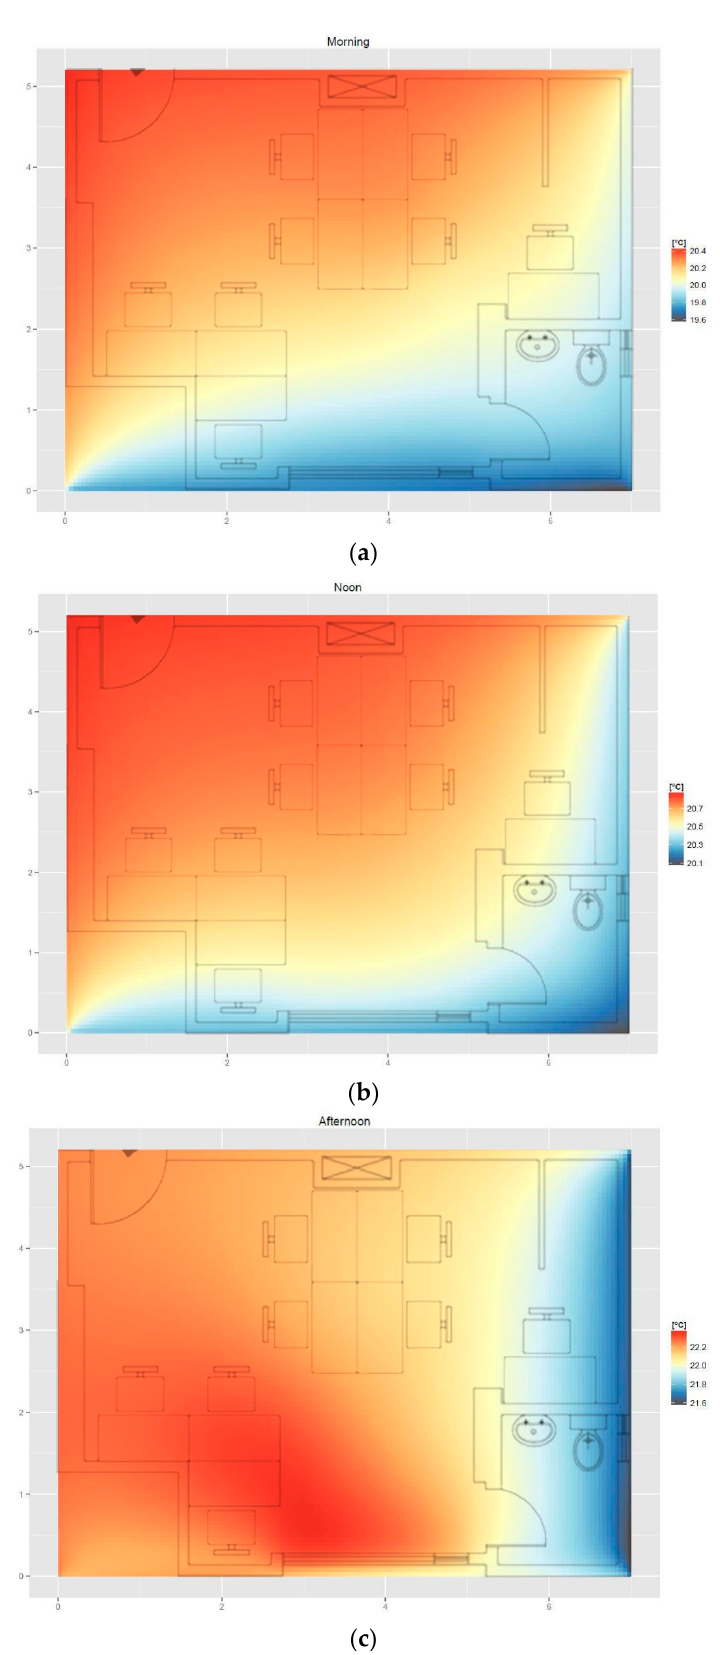
Figure 5. Spatial distribution of average indoor operative temperature ( a ) in the morning; ( b ) midday; and ( c ) afternoon.